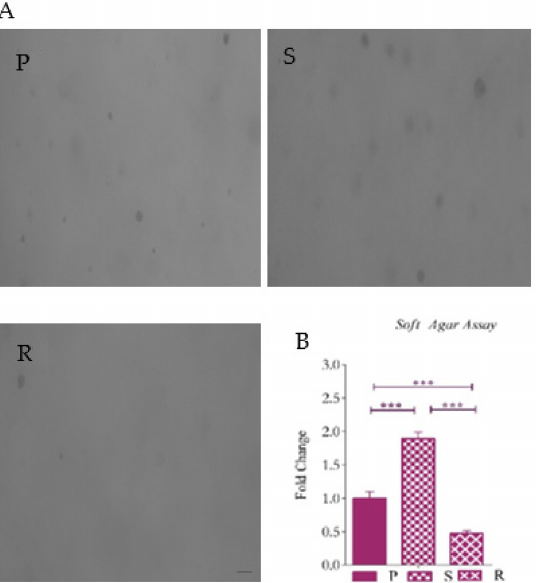
Figure 7. Soft agar colony-forming assay. Representative images of ( A ) P cells, S cells and R cells in soft agar. ( B ) Graph of the fold change of the number of colonies counted after 15 days of incubation. The graphical data are presented as mean ± SD, and the statistical analysis was performed using one ‐ way ANOVA (***: p ‐ value < 0.001). The scale bar indicates 20 μ M. To further confirm the self ‐ renewing potential of these cells, we looked for the ability of single cells of each type to form spheres in non ‐ adherent growth conditions. The per ‐ centage efficiency of colony formation was found to be 28.57%, 66.67% and 3.09% in P, S and R, respectively. The significant increase in sphere size was observed in these single cell colonies from S population as well. The resistant pool of cells formed spheres, but their smaller size suggested the inability of these cells to multiply continuously. 2.7. The Trypsin ‐ Sensitive Population of Cells Showed Better Proliferation and Migration Potential Next, we studied the proliferation potential of these cell types in both serum ‐ contain ‐ ing and serum ‐ free media (Figure 8A,B). It was observed that the S cells showed no sig ‐ nificant proliferation potential in adherent growth conditions in comparison to P and R cells. There was no significant difference in proliferation between the P and R populations. However, in SFM, these cells showed an increased rate of proliferation compared to the other pools. This added to the existing evidence supporting the presence of a more CSC ‐ like phenotype in the S pool. We performed in vitro wound healing assay [34] to understand migration in these cells. The cells grown in monolayer were scratched, and after 12, 24 and 36 h in serum starved conditions, the data were collected. We quantified the migration using the area method. The area of the gap that was covered at the time points was 46%, 64% and 78%, respectively, in P; 52%, 77% and 92%, respectively, in S; and 41%, 67% and 74%, respec ‐ tively, in R cells (Figure 8C,D).